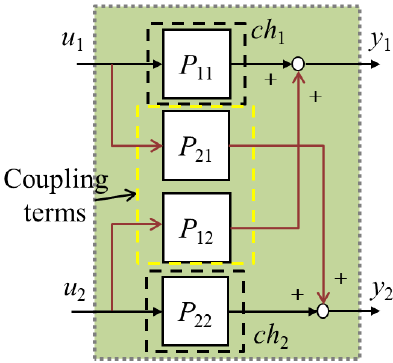
Figure 2. Block diagram of the two-input two-output (2I2O) controlled object.